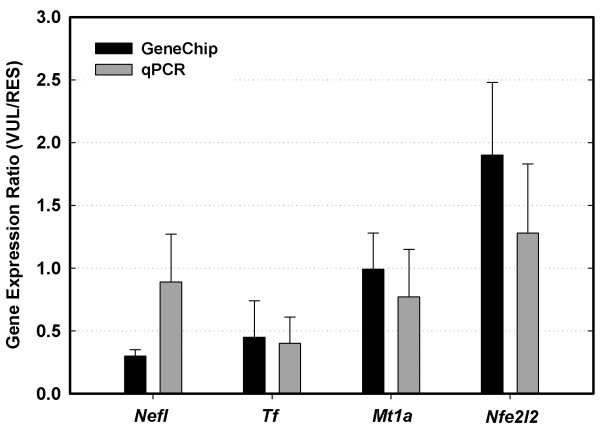
Validation of microarray data by real-time qPCR. Shown are the average ratios (± SEM, n = 3) of expression of the genes Mt1a, Nefl, Nfe2l2, and Tf, in VUL vs. RES neurons as measured by GeneChip and qPCR. The qPCR measurements are not significantly different from the GeneChip data (P values range: 0.199 – 0.896).